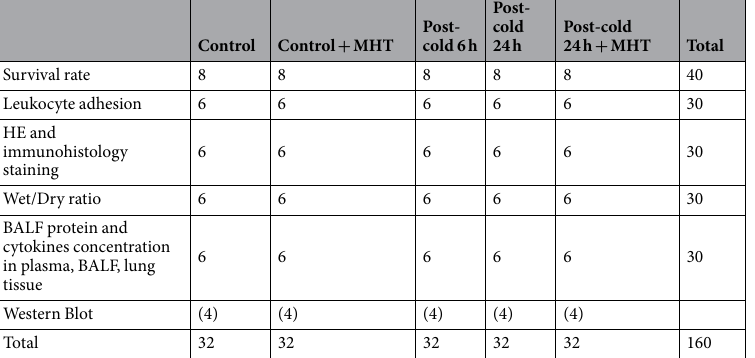
Table 1. Number of animals for different experimental groups and various parameters. The same animals were used for determination of survival rate. The same animals were used for determination of H&E and immunohistochemistry staining. The same animals were used for determination of BALF protein and the cytokine concentrations in plasma, BALF and lung tissue, as well as for western blot analysis. Control, Control group; Control + MHT, Control group plus MHT post-treatment; Post-cold 6 h, Post-cold 6 h group;